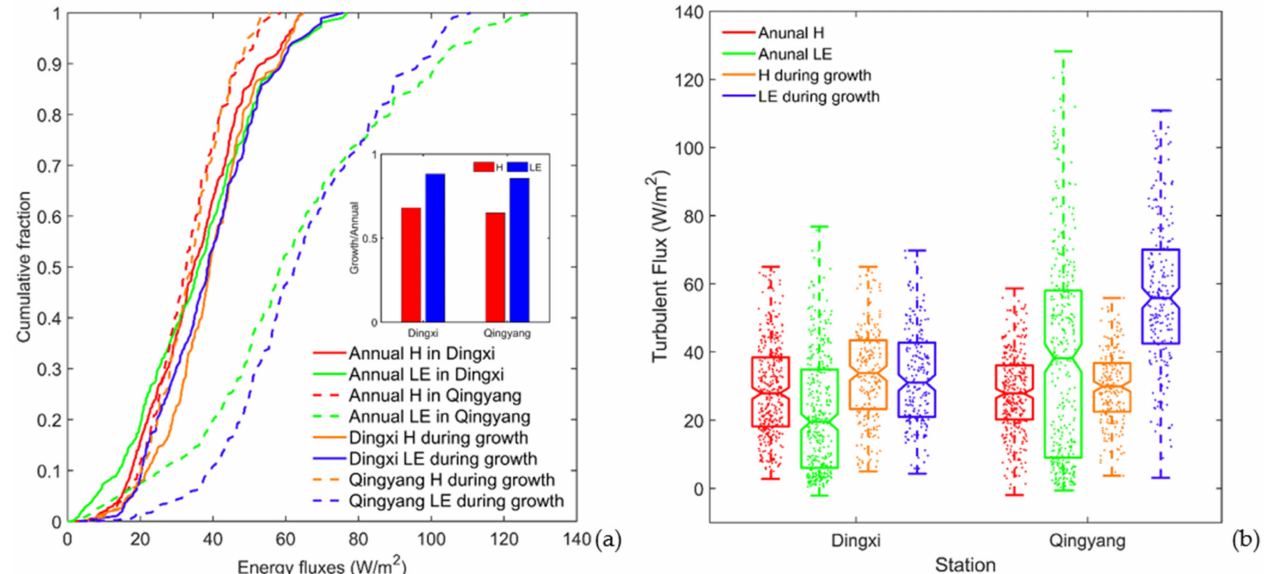
Figure 8. Cumulative fraction curve ( a ) and box plot ( b ) of the sensible and latent heat fluxes in Dingxi and